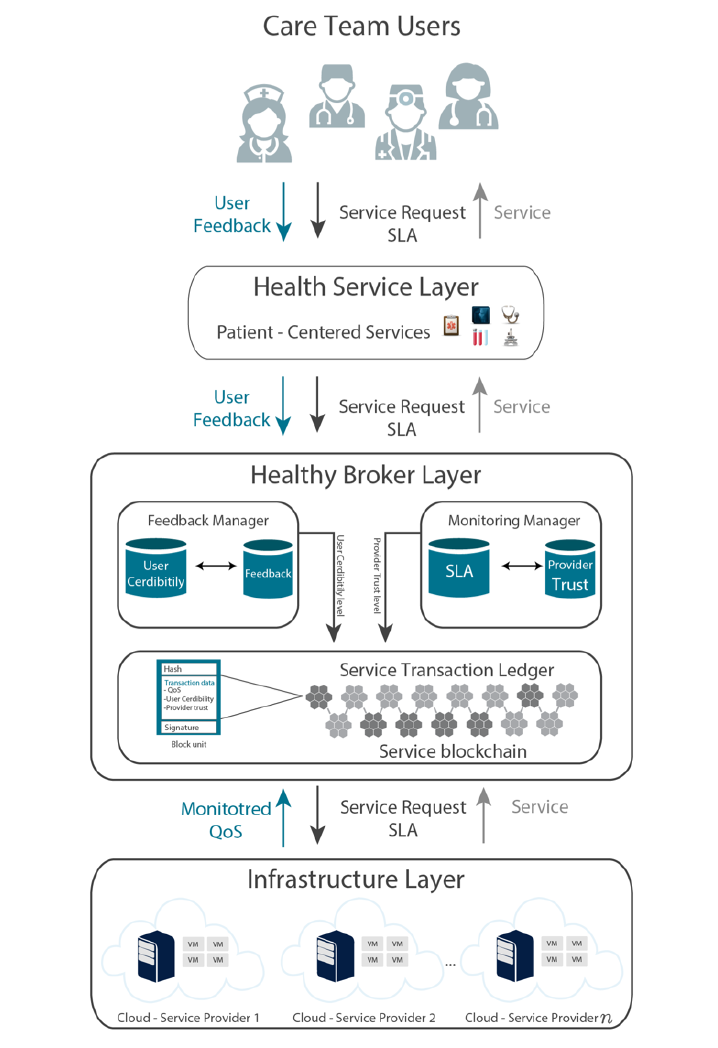
Figure 2. HealthyBroker architecture. Service level agreement (SLAs), quality of service